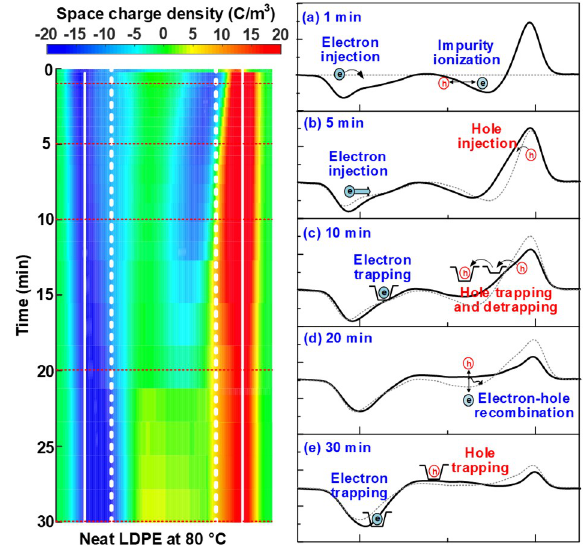
Figure 5. Space charge dynamic behaviors in the neat LDPE sample under +30 kV/mm at 80 °C. The polarization time is ( a ) 1 min, ( b ) 5 min, ( c ) 10 min, ( d ) 20 min and ( e ) 30 min, respectively.